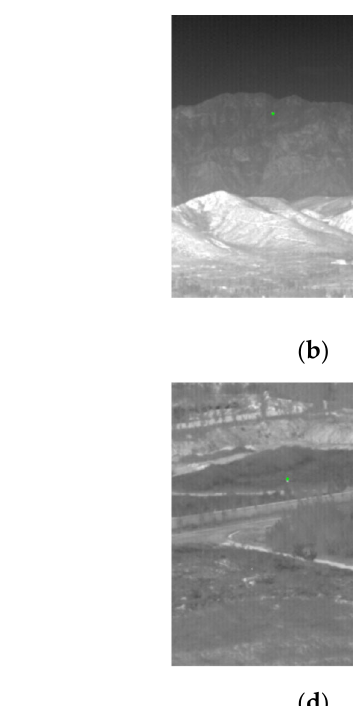
Figure 7. The figure shows the OKS scatter plot of the ablation experiment, with the horizontal coordinate showing the different OKS thresholds and the vertical coordinate showing the proportion of test samples meeting the current OKS threshold to the total test samples.